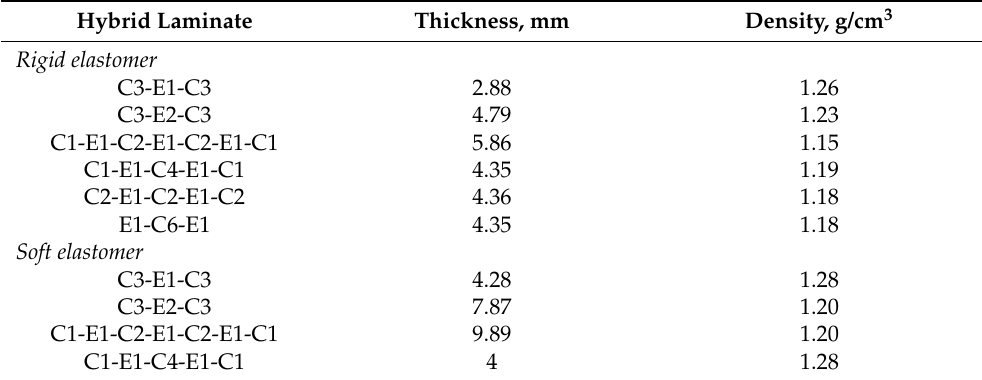
Table 2. Thickness and density of molded hybrid composite laminates. Hybrid Laminate Thickness, mm Density, g/cm 3 Rigid